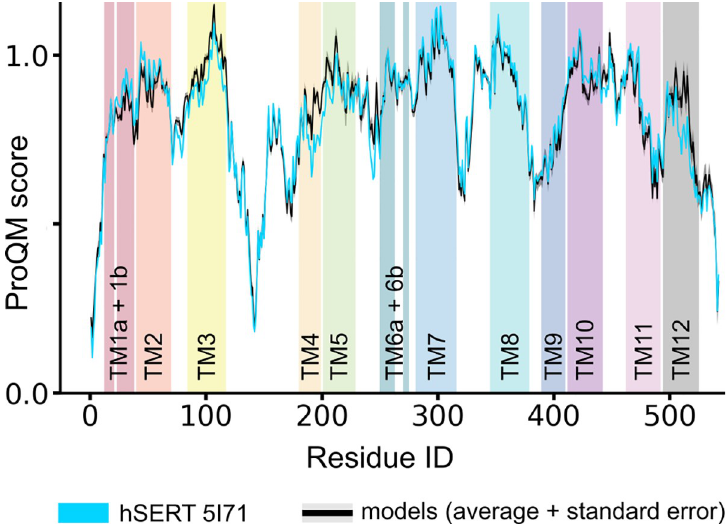
Fig 4. ProQM plot. Plot of the local ProQM structural model quality scores for each residue in the X-ray structure (hSERT 5I71, cyan) and the 16 best ranked models (average in black, standard errors in gray). The ProQM plot shows a clear quality comparability between experimental and modeled structures and a striking consistency amongst the models.